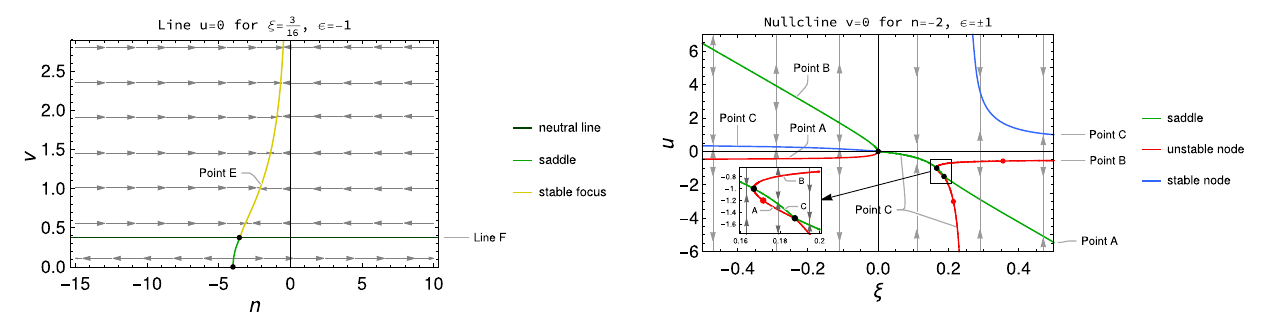
Fig. 9 Bifurcation diagram of the local stability of equilibrium points Fig. 8 Bifurcation diagram of the local stability of equilibrium points of system (25) on the v = 0 nullcline under variation of the parameter of system (25) on the u = 0 line under variation of the parameter n ξ for fixed n = − 2 and ε = ± 1. Black dots in this diagram denote for fixed ξ = 3 and ε = − 1. Black dots in this diagram denote a 16 a non-hyperbolic equilibrium point, while red dots denote an unstable non-hyperbolic equilibrium point. Grey arrows show the direction of proper node. Grey arrows show the direction of the flow on the nullcline the flow on the u = 0 line – arrows directed to the right denote the flow following towards increasing values of u , whereas arrows directed to the left denote the flow following towards decreasing values of u . The flow on the u = 0 line is perpendicular to this line since on it v (cid:7) = 0 in system (25)